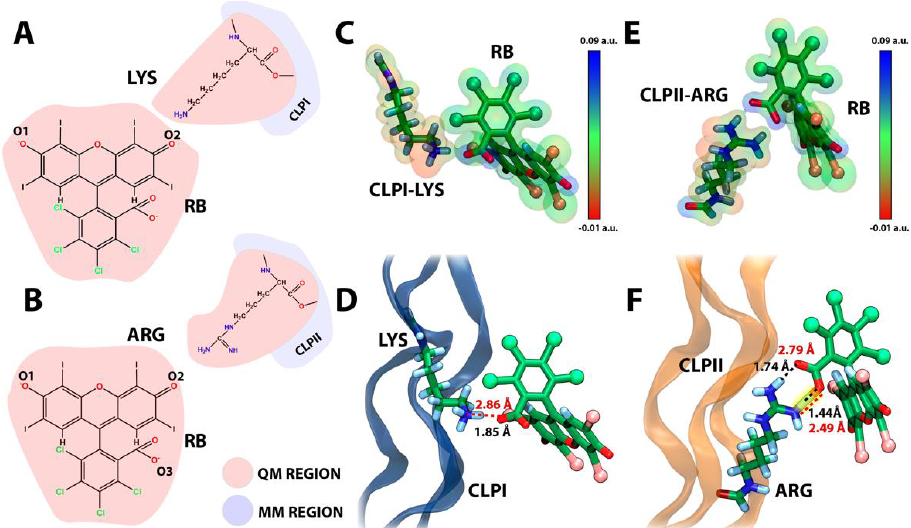
Figure 4. Evaluation of interaction of RB and CLPs with QM/MM method. ( A , B ) Representative scheme of region selection for QM/MM calculations in RB-CLPI and RB-CLPII systems, respectively; ( C ) Electronic density of QM region of the last QM/MM simulation frame of RB-CLPI system; ( D ) Structural representation of the last simulation frame for the CLPI-RB system; ( E ) Electronic density of QM region of the last QM/MM simulation frame of RB-CLPII system; and ( F ) Structural representation of the last simulation frame for the RB-CLPII system, yellow highlight emphasizes the formation of a strong hydrogen bond.